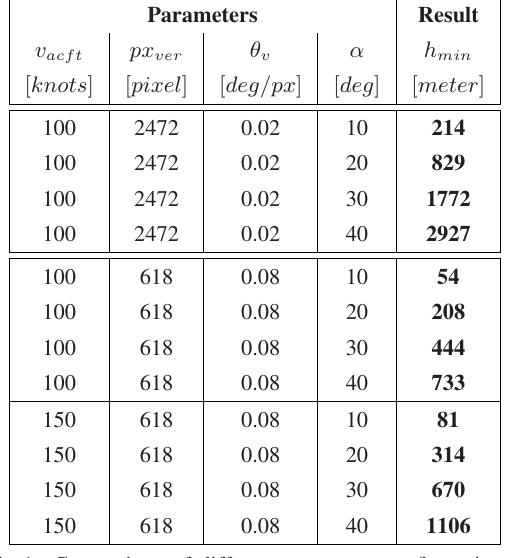
Table 1: Comparison of different parameter configurations re- quired for the pure rotation assumption in between two consecu- tive frames and the resulting minimal required altitude h min : air- craft speed v acft , vertical resolution in pixel px ver , vertical an- gular resolution θ v and feature angle α . In addition to the values specified in the table we assume a constant frame rate of 20 fps and a vertical field of view of 51 ◦